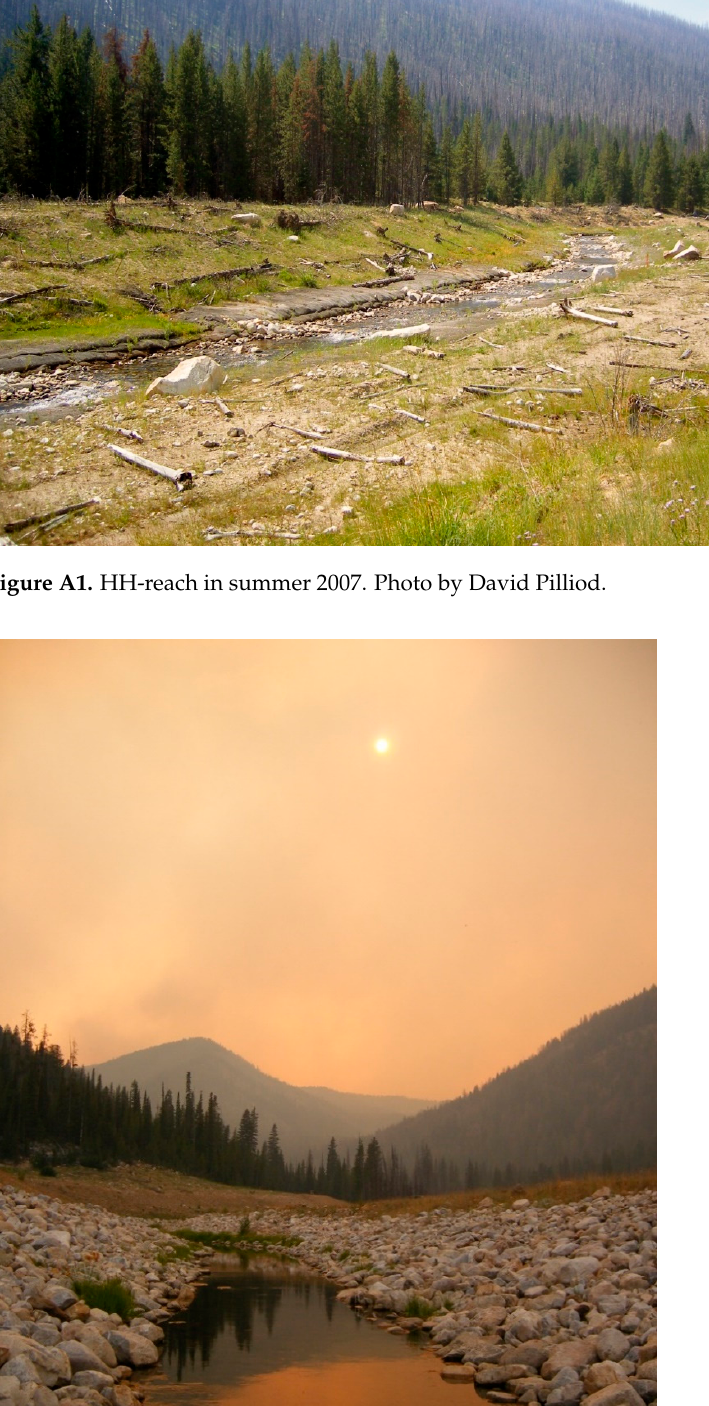
Figure A3. Downstream-reach in summer 2007. Photo by Robert Arkle.